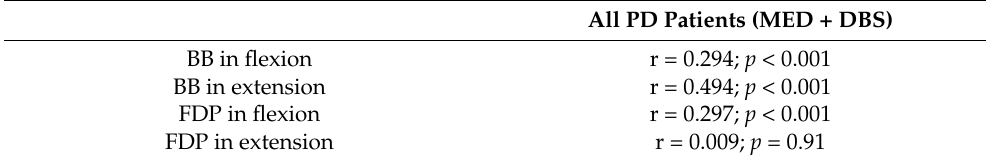
Table 3. Spearman’s Rho correlation (r) between MDS-UPDRS-III (‘22b-c’) and shear wave velocity (SWV) over 80 min for all patients (therapy with and without DBS), broken down by muscle group and position (r), showing a positive correlation of the UPDRS with SWV. This trend is most evident for the biceps brachii (BB) in extension.